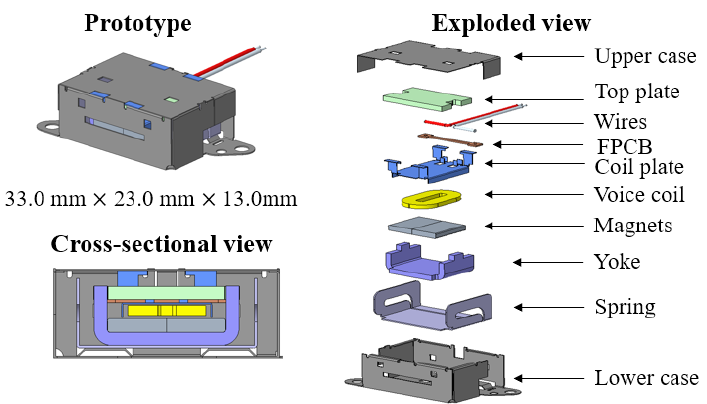
Figure 2. HLVM prototype.